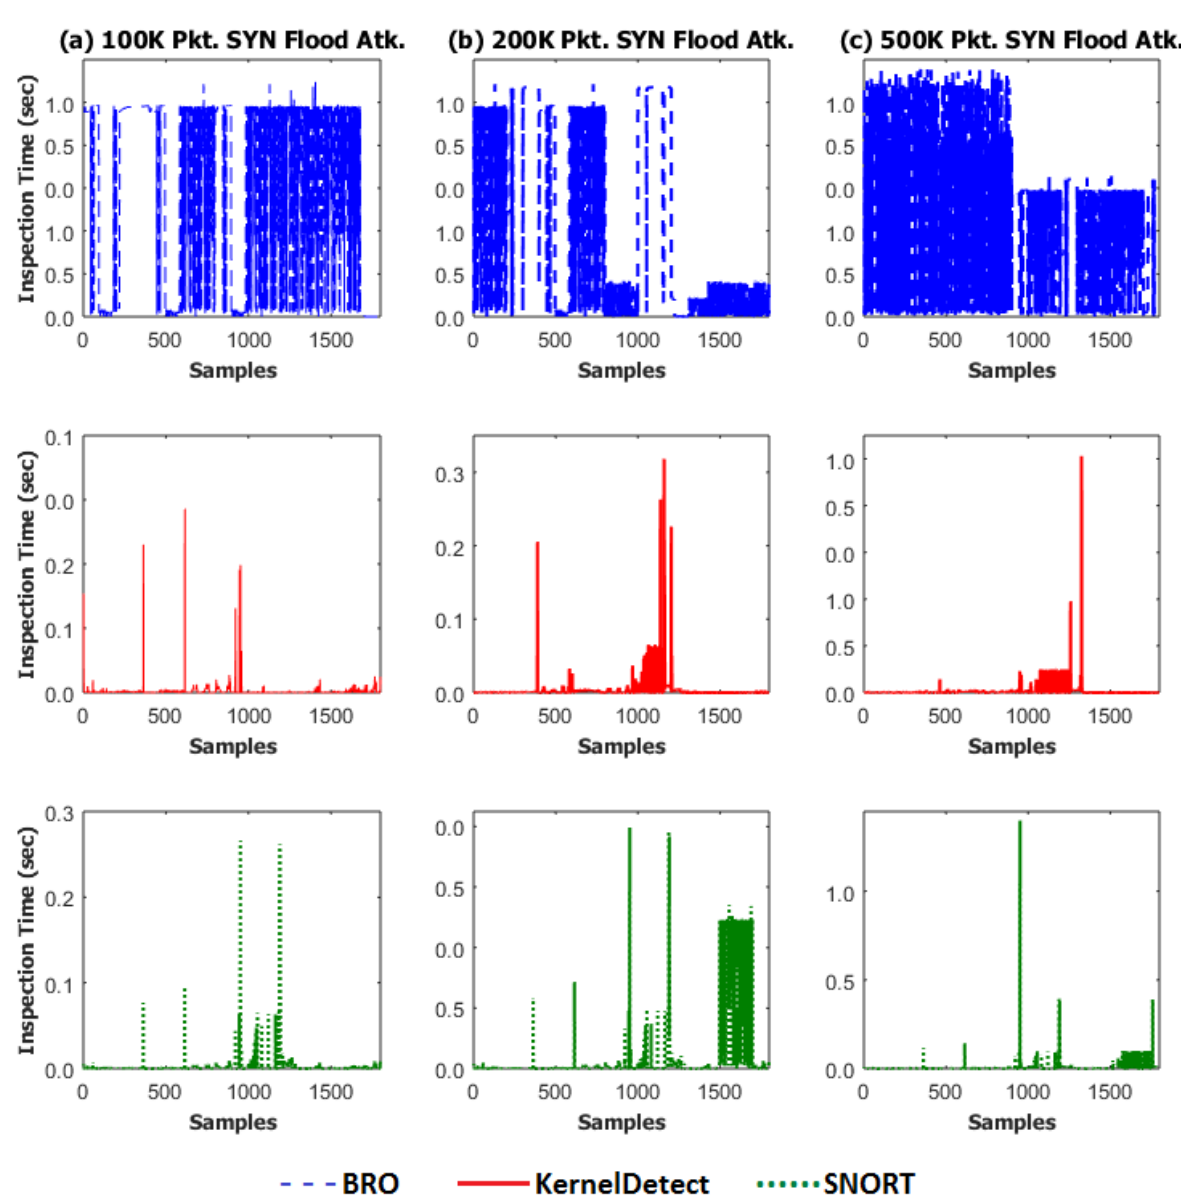
Figure 6. comparative analysis of the inspection time for each IDS under 100K, 200K and 500K SYN flagged packet DoS attack using a 15 second threshold